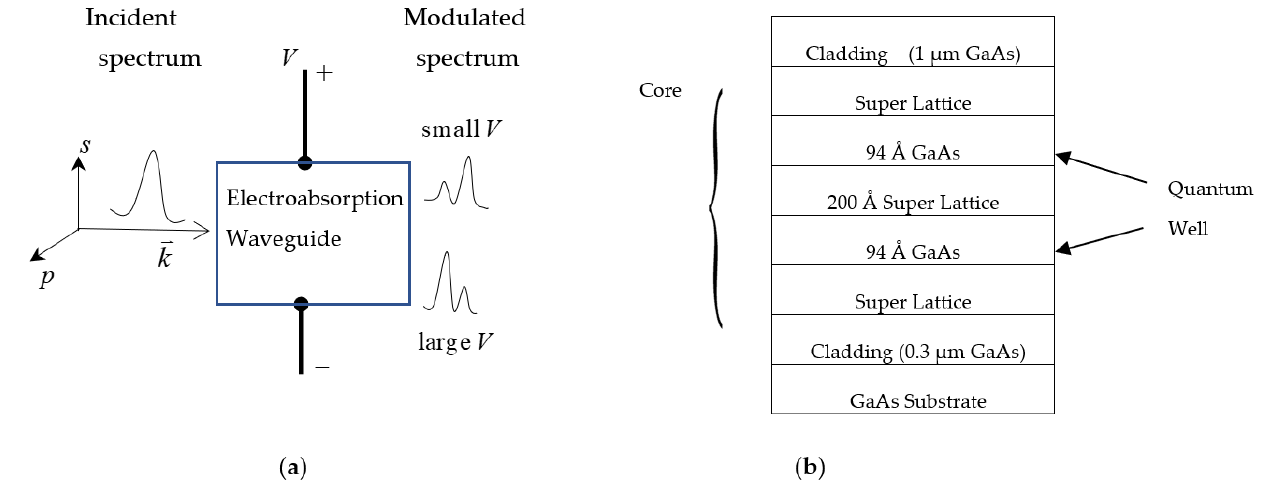
Figure 2. ( a ) The waveguide device configuration used in spectrum peak shift control. ( b ) The waveguide schematic structure.